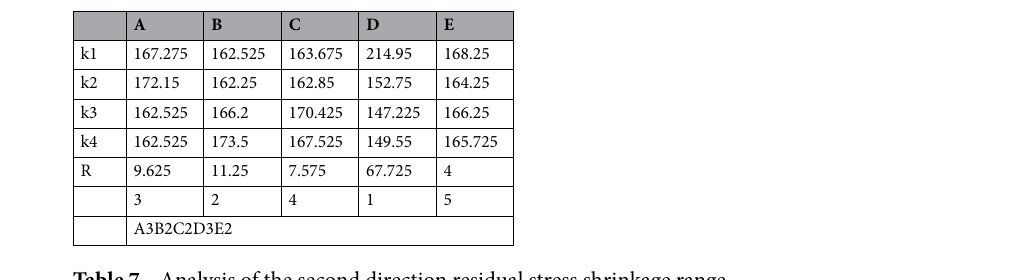
Table 7. Analysis of the second direction residual stress shrinkage range.